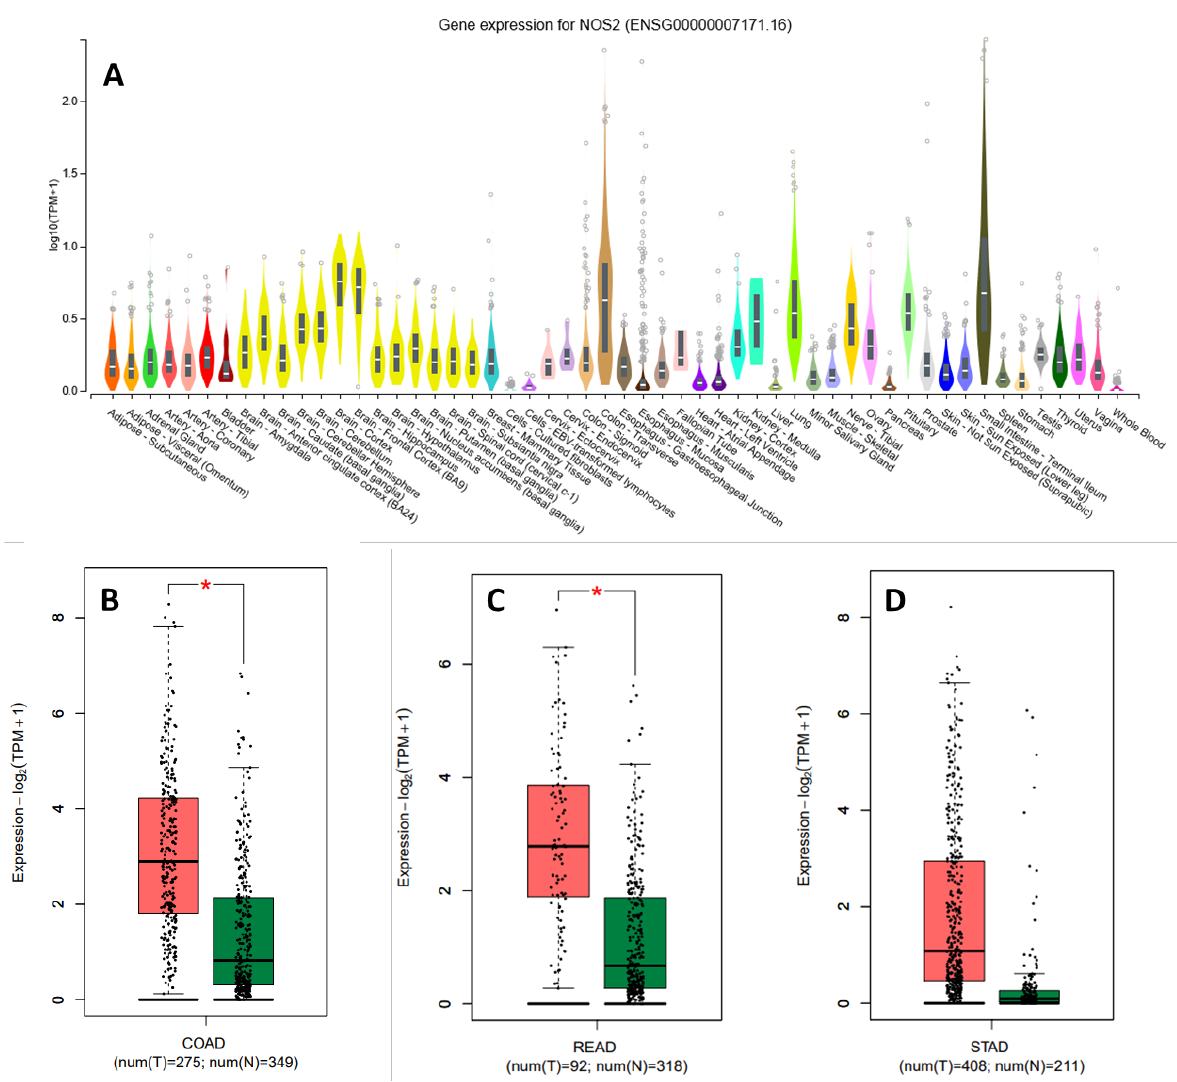
Figure 1 : iNOS/NOS2 mRNA relative expression analysis (A: iNOS/NOS2 gene mRNA relative expression in human body tissues; B: iNOS/ NOS2 gene mRNA relative expression between tumor tissue and normal tissue of colon cancer; C: iNOS/NOS2 gene mRNA relative expression between tumor tissue and normal tissue of rectal cancer. D: iNOS/NOS2 gene mRNA relative expression between cancer tissue and normal tissue of gastric